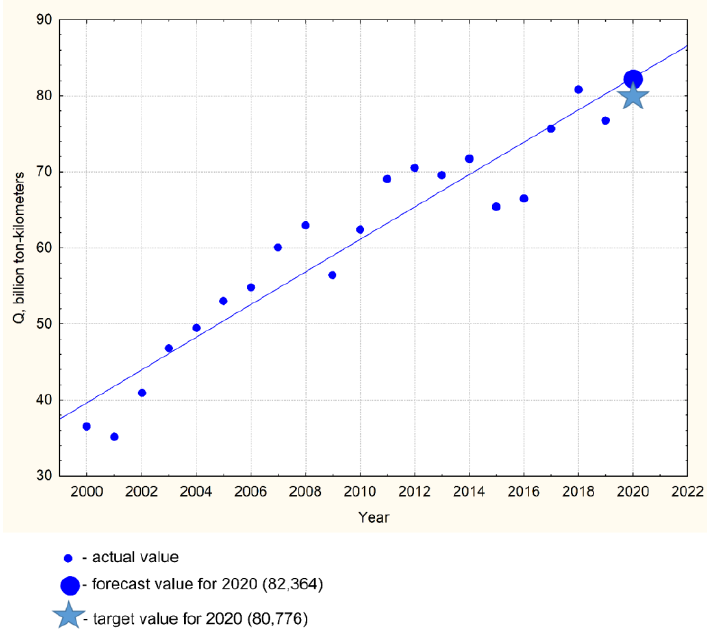
Figure 7: Assessment of the attainability of the goals for the completed cargo turnover